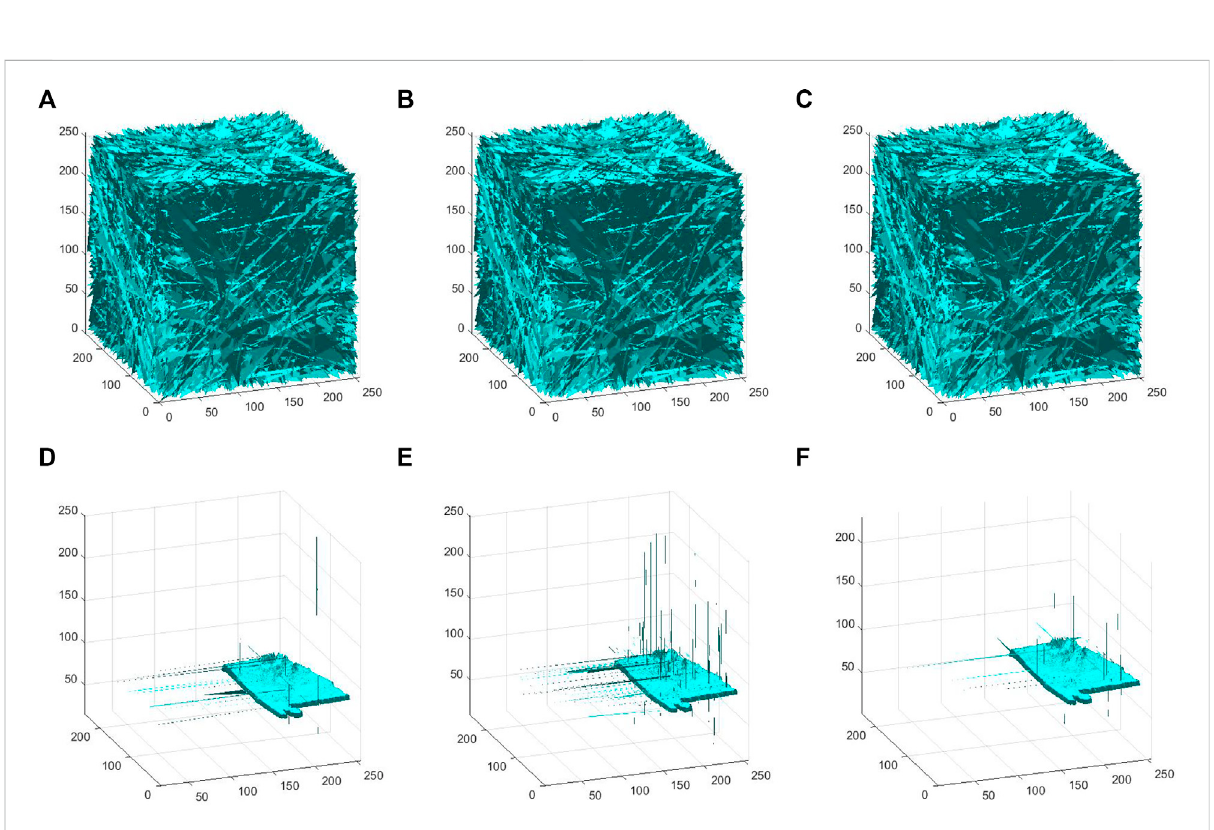
FIGURE 14 Robustness analysis of United States. (A) Ciphertext of data loss 10 groups. (B) Ciphertext of data loss 50 groups. (C) Ciphertext of 0.0001 salt and pepper. (D) Decrypted image of (A) . (E) Decrypted image of (B) . (F) Decrypted image of (C)